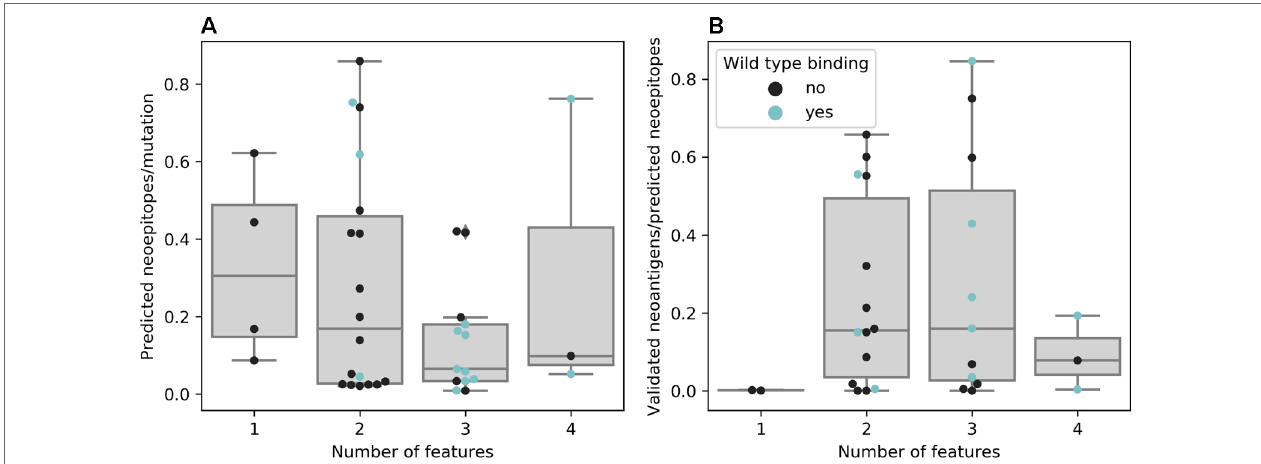
FIGURE 3 | (A) Neoepitopes per mutation grouped by the number of features used for neoepitope selection. Data based on publications that offered comparable data, e.g., not obviously counting a neoepitope predicted to be presented by multiple major histocompatibility complexes (MHCs) multiple times (n = 38). (B) Ratio